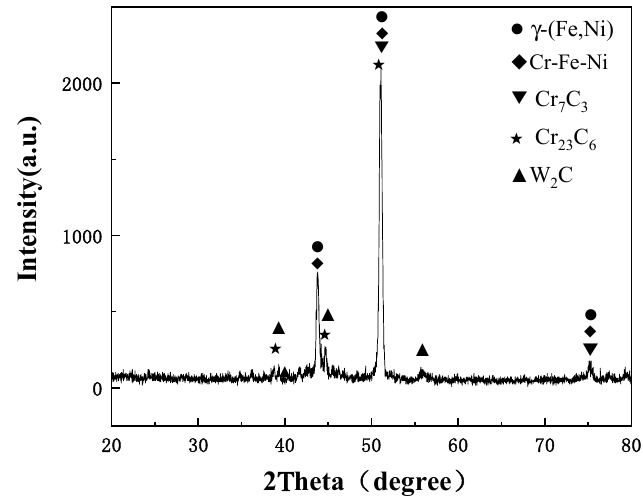
Figure 5. XRD analysis results of the coating.